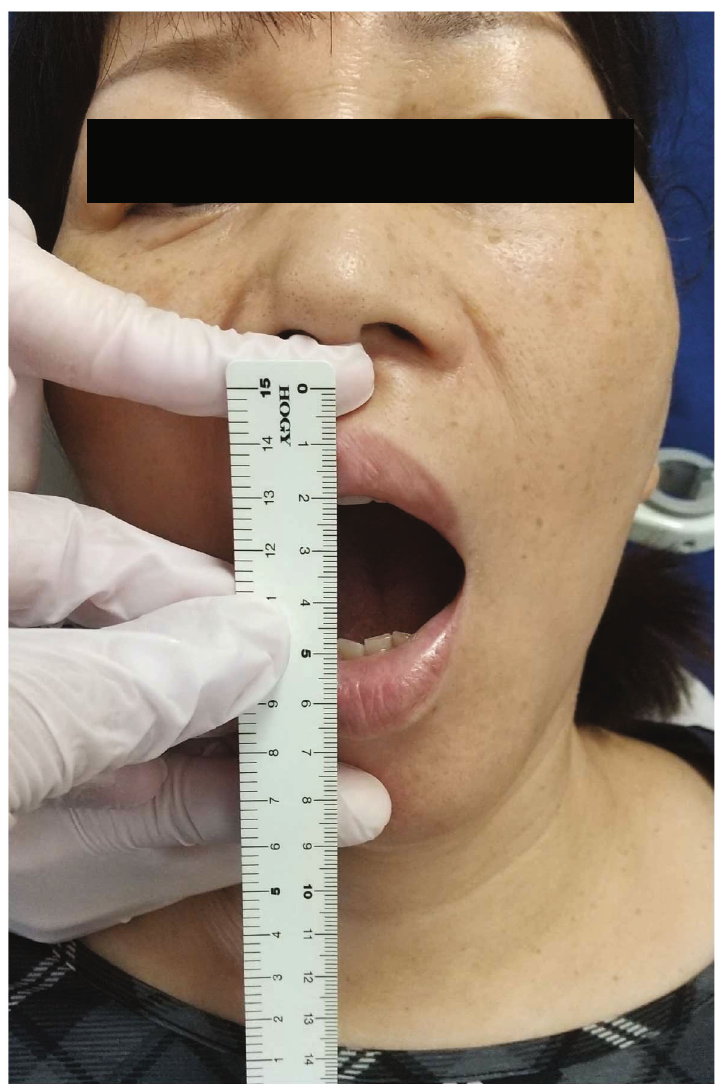
Figure 5: After the fi rst session of JMUI